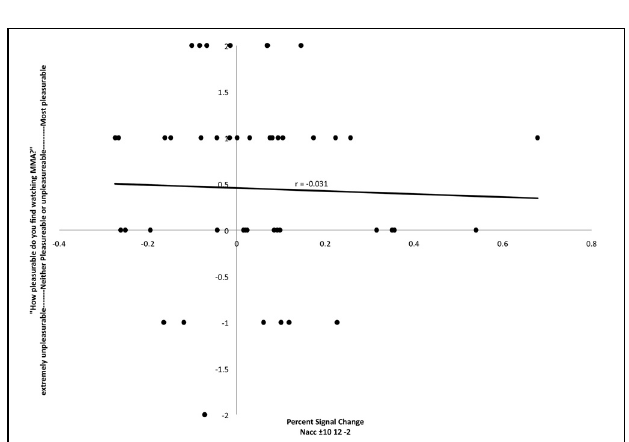
FIGURE 1 | Whole brain analysis showing BOLD signal changes in 49 male participants while watching videos depicting a full contact, Mixed Martial Arts (MMA, in red) vs. control videos depicting Capoeira (Control, in blue).